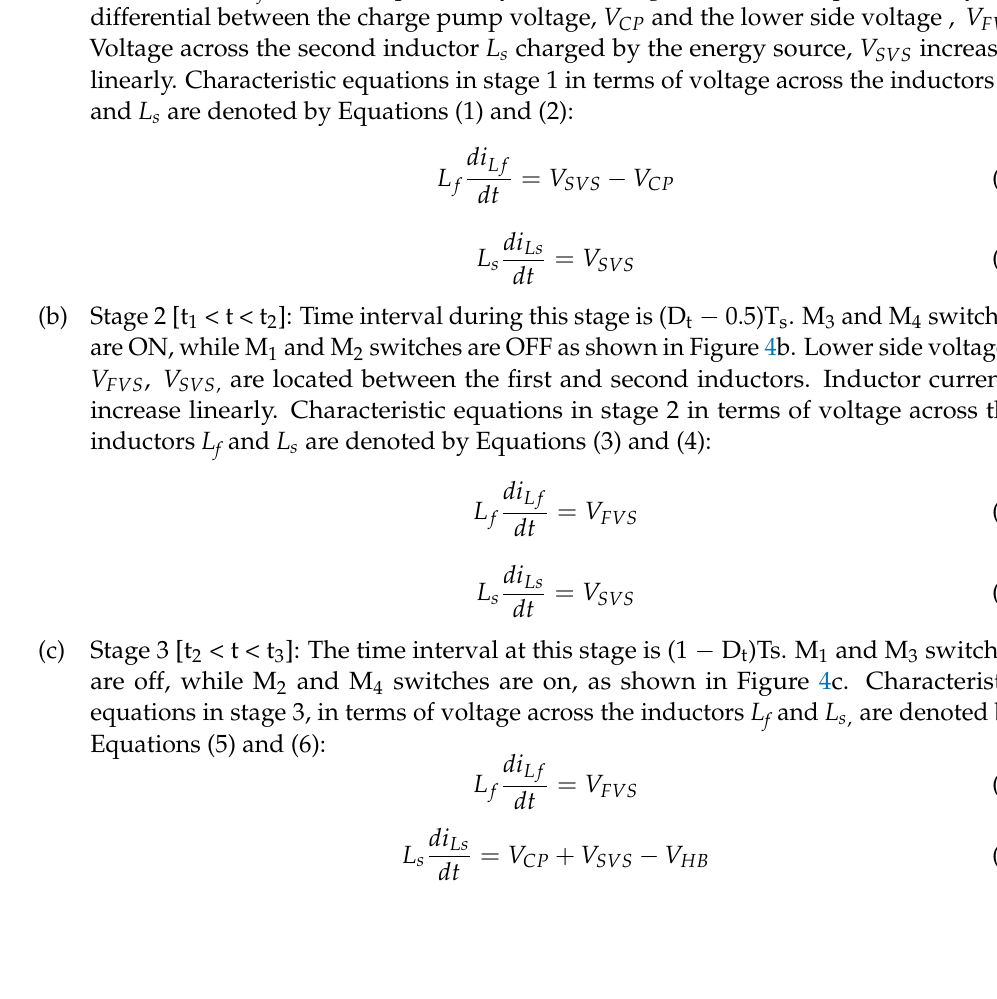
Stage 3 [t 2 < t < t 3 ]: The time interval at this stage is (1 − D t )Ts. M 1 and M 3 switches are off, while M 2 and M 4 switches are on, as shown in Figure 4c. Characteristic equations in stage 3, in terms of voltage across the inductors L f and L s , are denoted by Equations (5) and